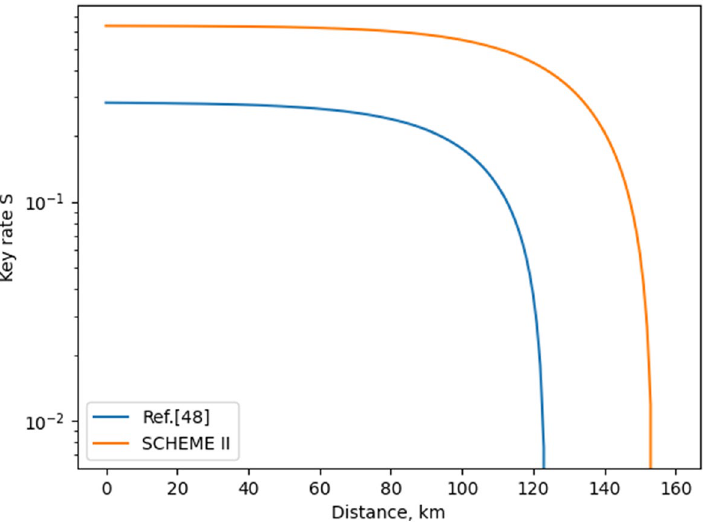
Figure 5. Key rates of classic relativistic schemes. Details on the parameters used to evaluate the rates of the distinct schemes are given in the Supplementary Material.